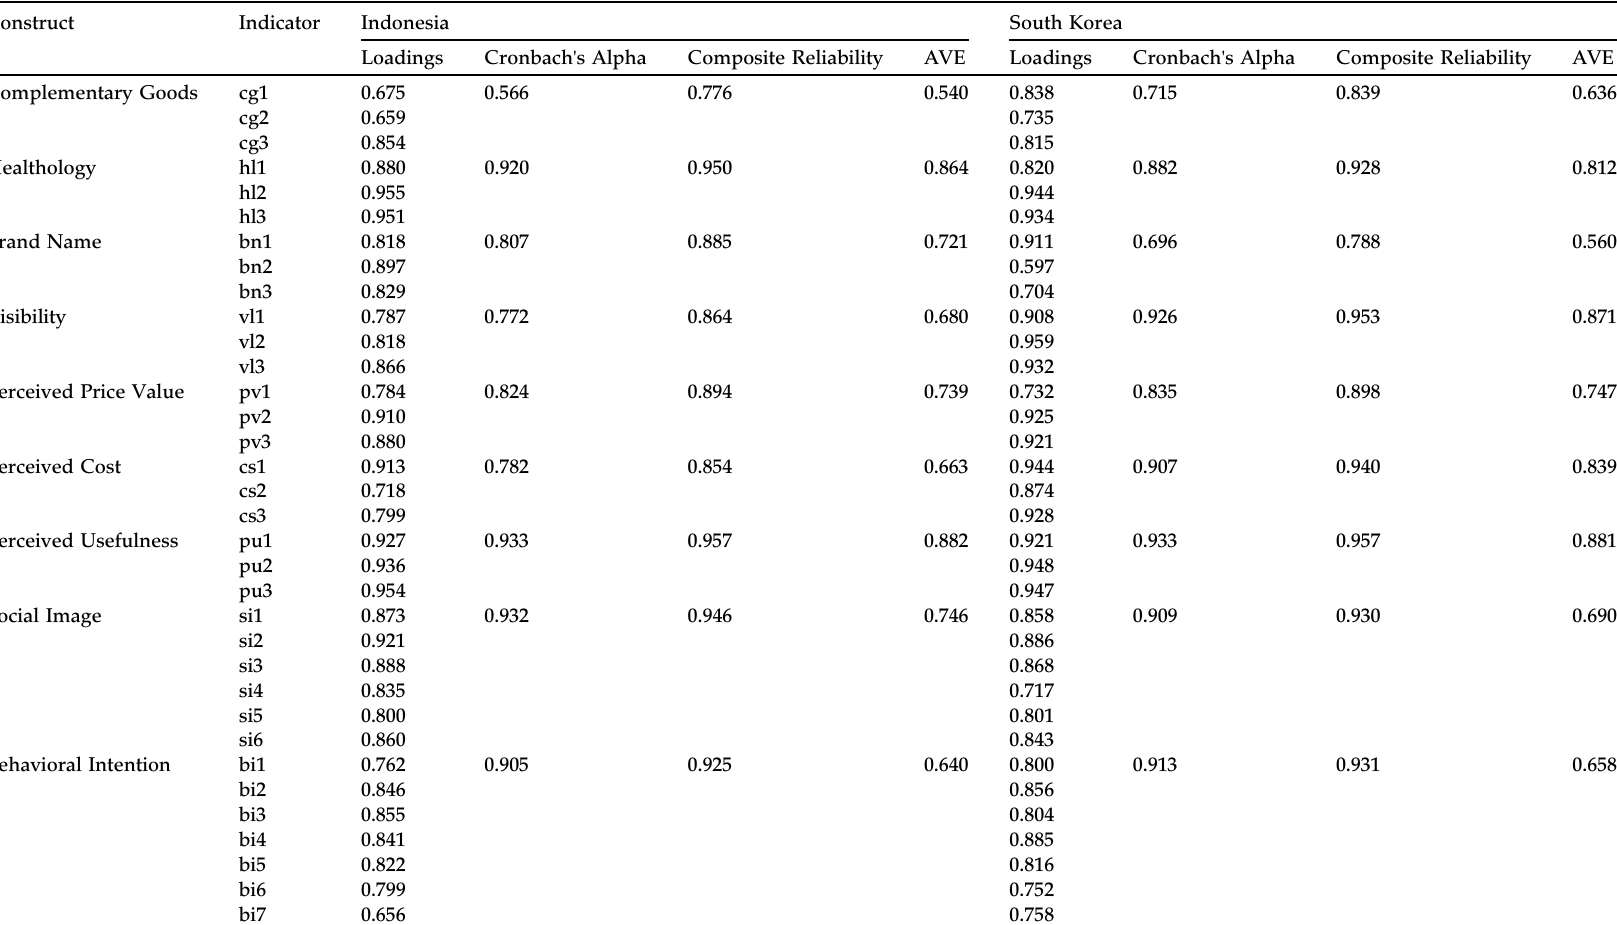
Table 3. Measurement model.